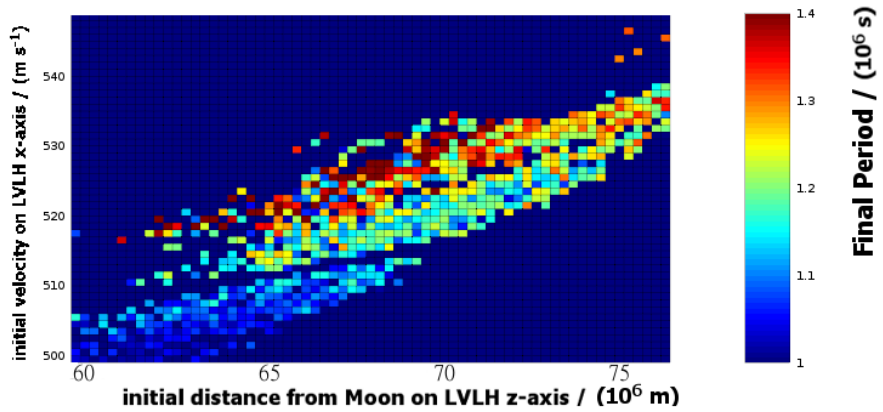
Figure 23. Detailed view of the final orbital period for the same initial conditions as Figure 22. The color-axis shows the period in